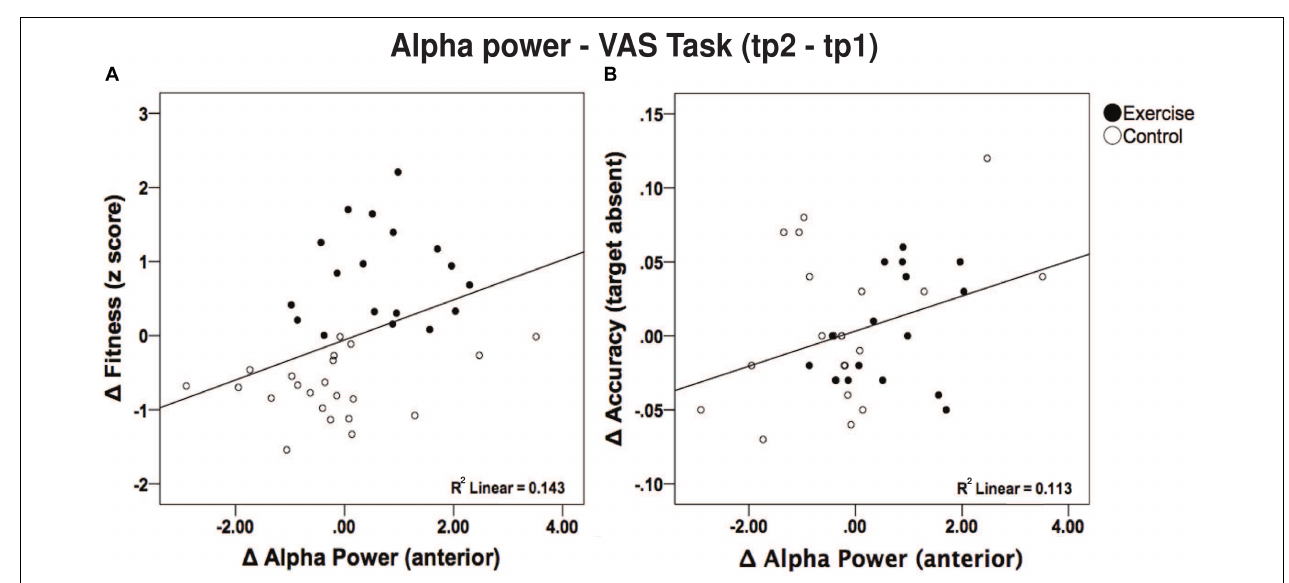
FIGURE 5 | (A) Bar graph shows the intervention-induced alpha power change during the VAS task at frontal and posterior clusters for each group. Asterisk indicates p < 0.05 (uncorrected, 2-tailed t -test). (B) Topographical distribution of ERSP values for alpha-band activity, including the first 3 s of the sample stimuli presentation in both the pre and post intervention